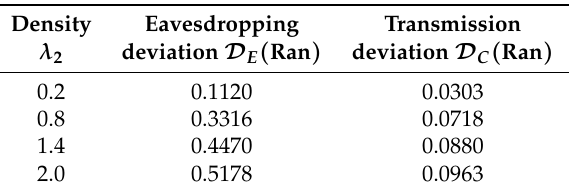
Table 2. Eavesdropping deviation and transmission deviation of comparing FJ-Ran scheme with Non-Jam scheme when T = 10 dB and α = 4.